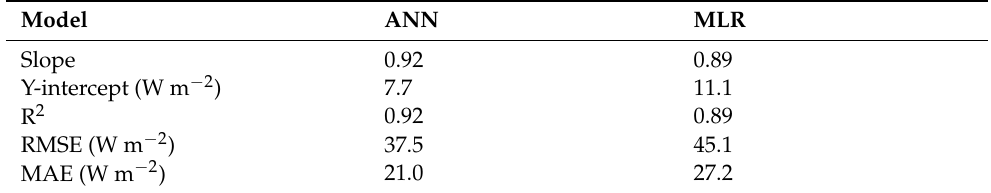
Table 2. Performance measures of ANN and MLR models using the entire data set of 2017 for training and validation. The Y and X axes of the regressions are the estimated and the measured half-hourly LE (W m − 2 ),